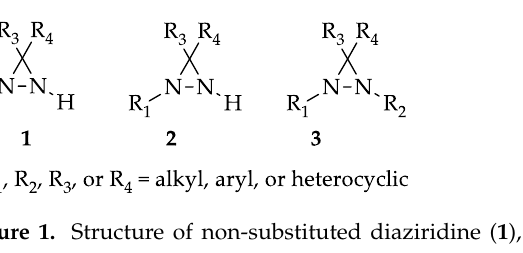
Figure 1. Structure of non-substituted diaziridine ( 1 ), N -monosubstituted diaziridine ( 2 ), N , N -disubstituted diairidine ( 3 ).